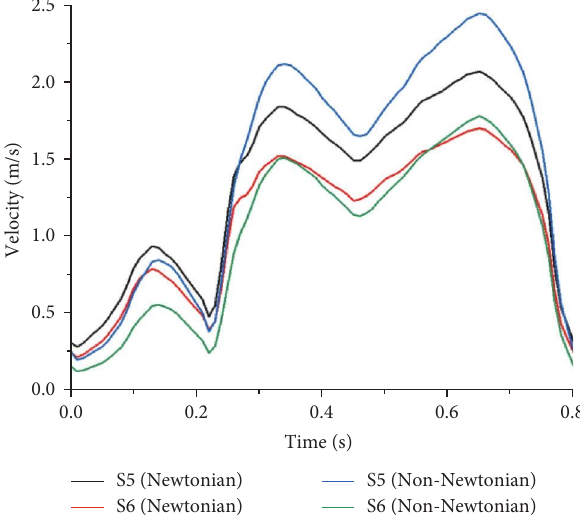
F IGURE 11: Maximum wall shear stresses at both ends of the